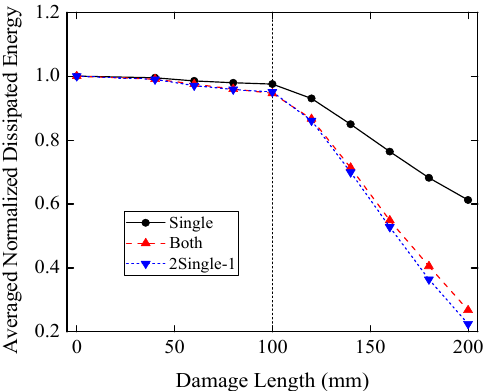
Figure 31. Averaged normalized dissipated energy of damaged models.